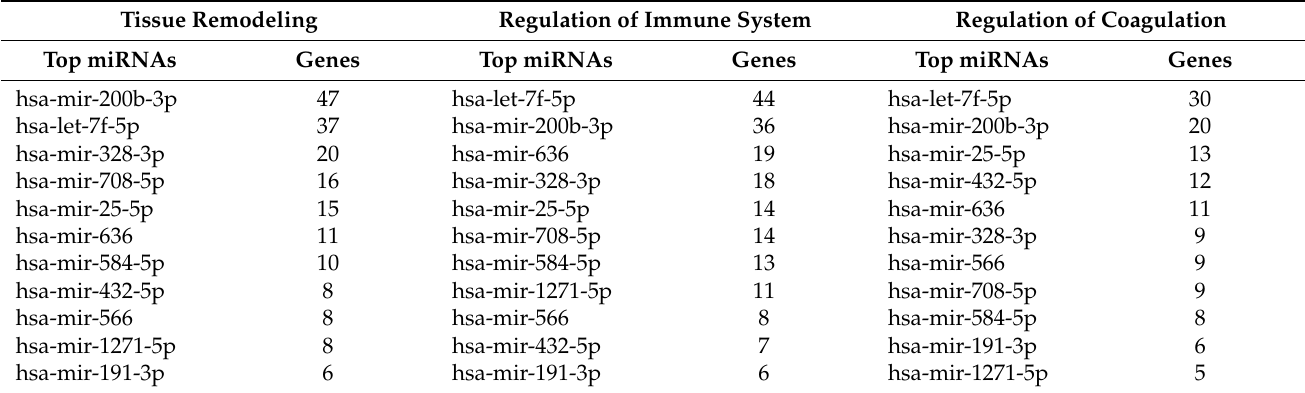
Table 2. Top ranked miRNAs and genes found in the network analysis.